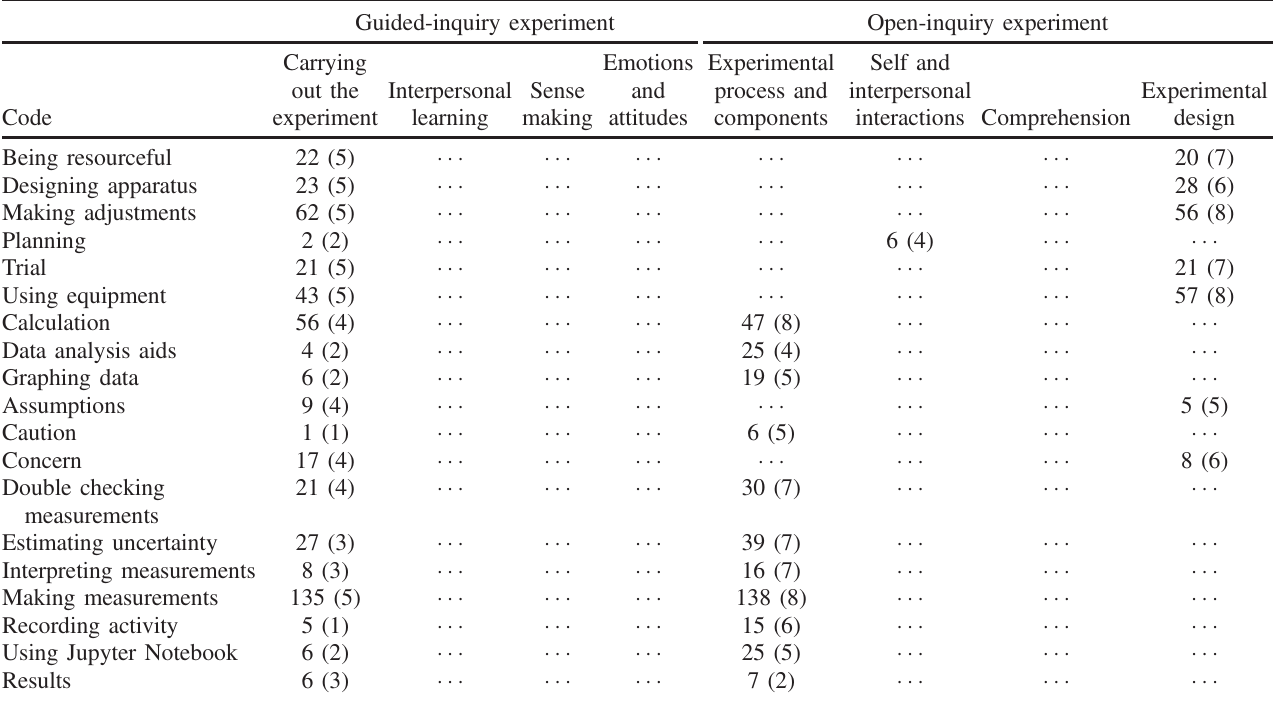
TABLE V. A list of the 40 common codes that emerged from qualitative coding analysis of the guided-inquiry data set and the open- inquiry data set. We list the 4 themes from the guided-inquiry experiment first, followed by the 4 themes from the open-inquiry experiment. The numbers shown in the table are how many times each code is referenced in the corresponding experiment and how many files each code is referenced (shown in parentheses). Note that the total number of guided- and open-inquiry files is 5 and 8,